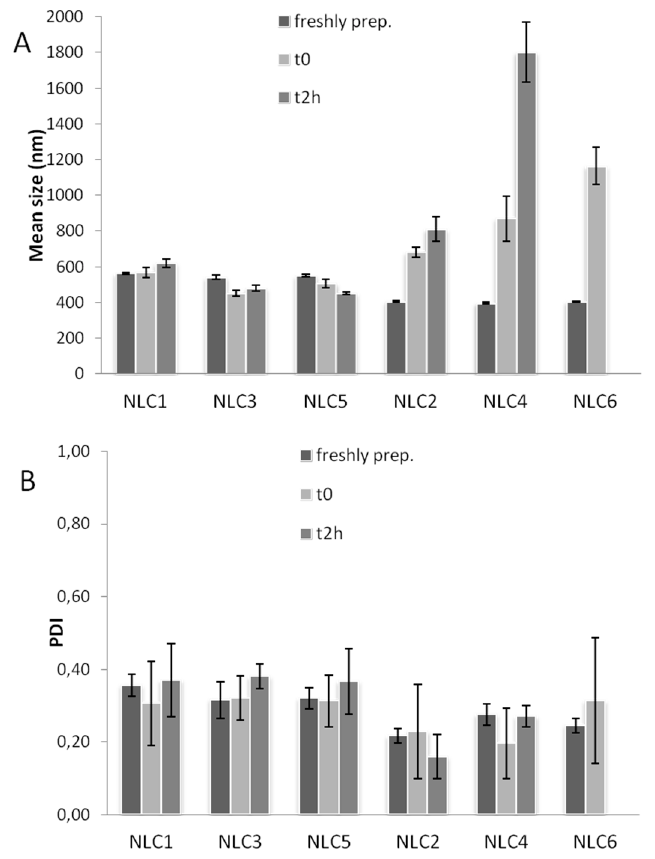
Figure 2. Gastric stability of Tween ® 80-based NLC (odd series) or Pluronic ® F68-based NLC (even series) in terms of mean size ( A ) and PDI ( B ).